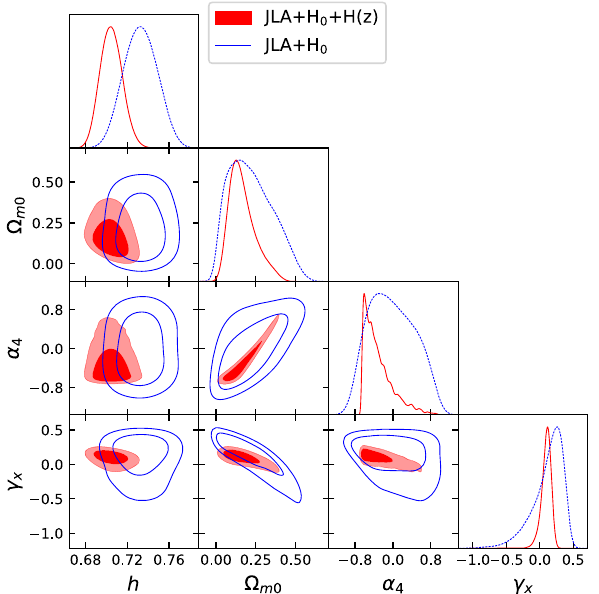
Fig. 5 The contour plot for interaction Q 4 with the 1 σ and 2 σ